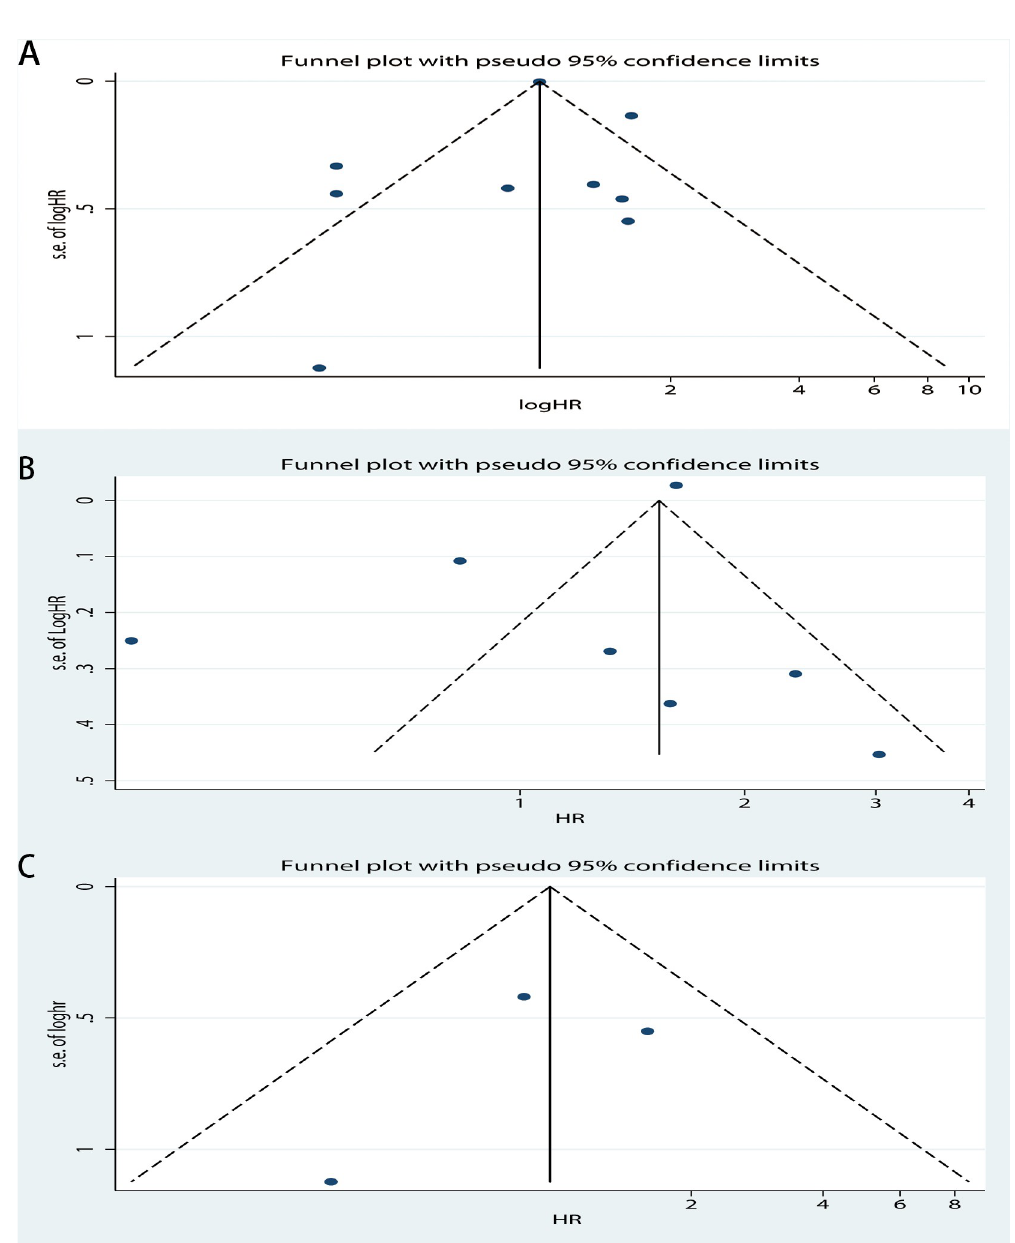
Fig 11. Funnel plot of CAIX expression and disease-free survival on A, all inclusion studies; B, by excluding the low quality score studies (quality score � 6); C, only including new studies (quality score �